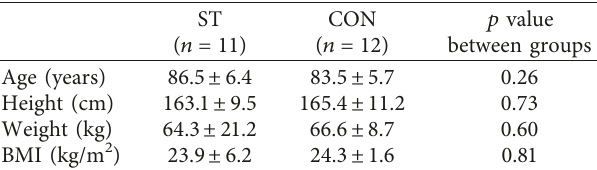
Figure 1: An overview of the study design. Table 1: Age, height, and BMI for both